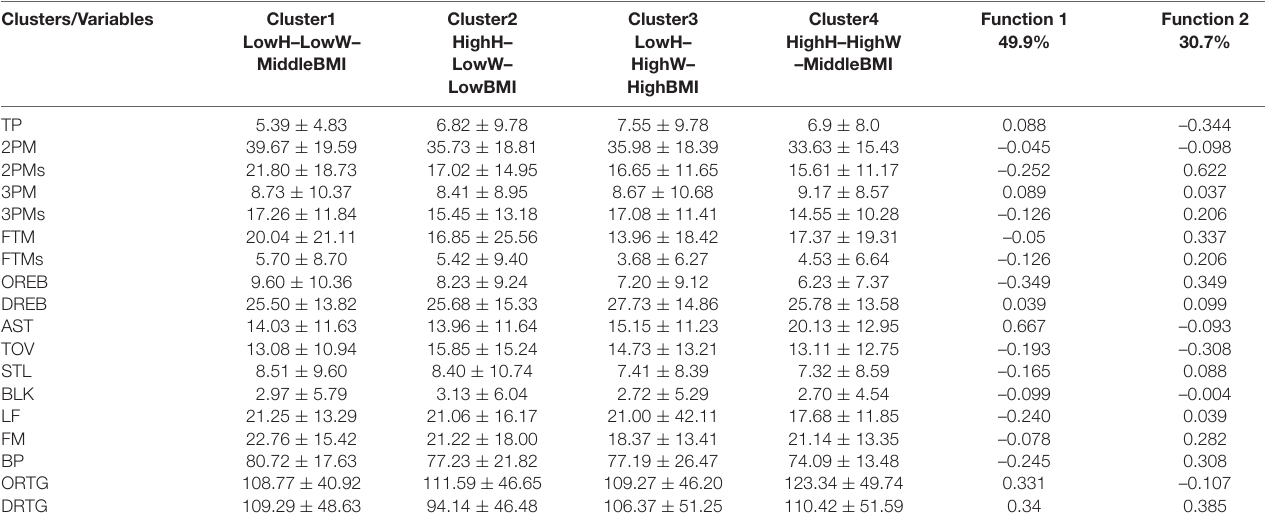
FIGURE 1 | The distribution of line-ups from different national teams within four cluster groups. Note: LowH–LowW–MiddleBMI: low average height and weight with middle BMI; HighH–LowW–LowBMI: high average height and low average weight with low BMI; LowH–HighW–HighBMI: low average height and high average weight with high BMI; HighH–HighW–MiddleBMI: high average height and weight with middle BMI. TABLE 3 | Discriminant analysis of different line-up